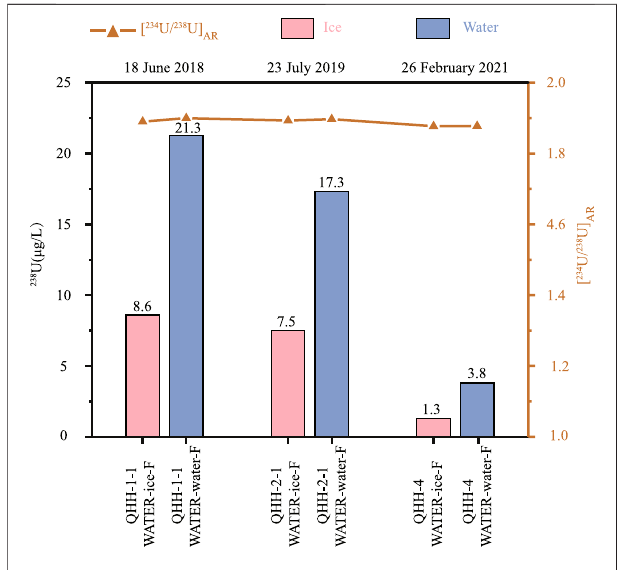
FIGURE 3 | Differences in 238 U concentration and [ 234 U/ 238 U] AR between ice and water obtained during the inhouse freezing experiments conducted on three batches of Qinghai Lake water